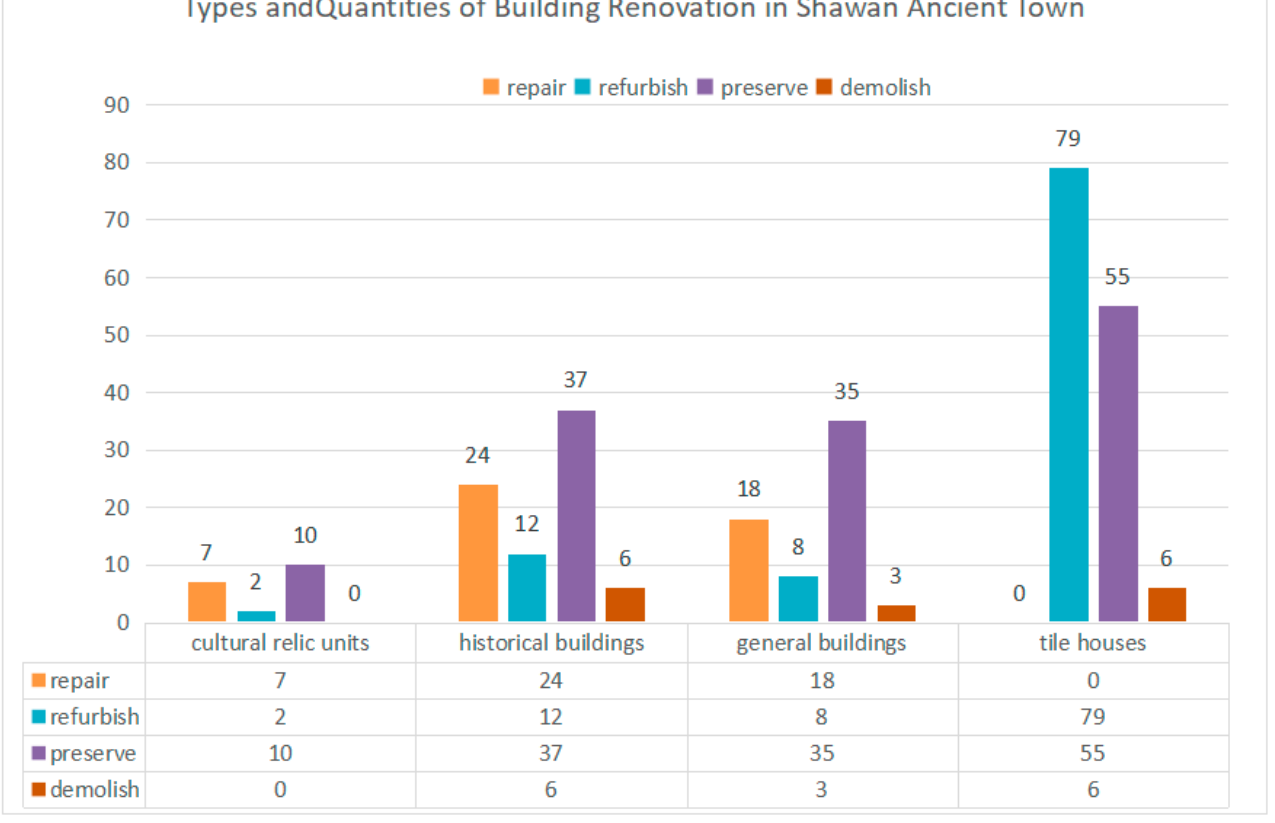
Figure 14. Types and quantities of building renovation in Shawan Ancient Town. (Source: the au- thors.)